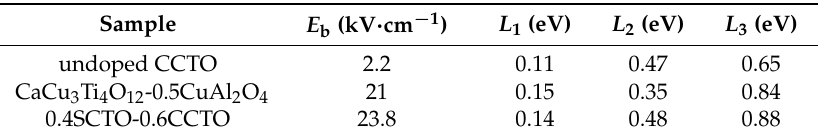
Figure 5. Frequency dependence of electric modulus in the temperature range of 153–433 K for CCTO ceramics ( a ), the CaCu 3 Ti 4 O 12 -0.5CuAl 2 O 4 composite ( b ), and the 0.4SCTO-0.6CCTO composite ( c ). Table 1. Electrical parameters of CCTO ceramics of undoped CCTO ceramics and CaCu 3 Ti 4 O 12 /CuAl 2 O 4 composite